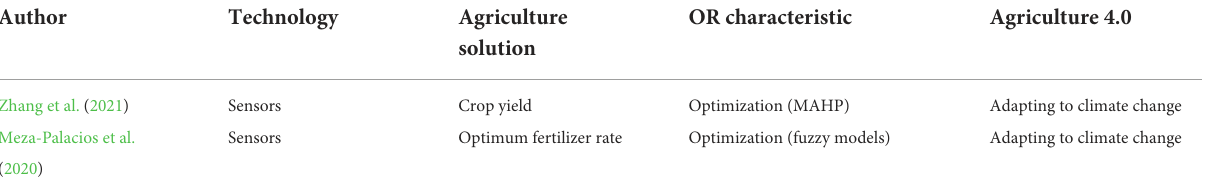
TABLE 10 Research stream: DSS to optimize fertilizer